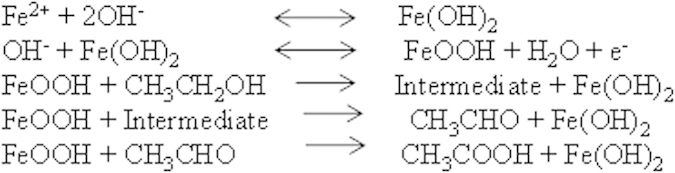
Ethanol oxidation mechanism at Fe3O4 electrode.